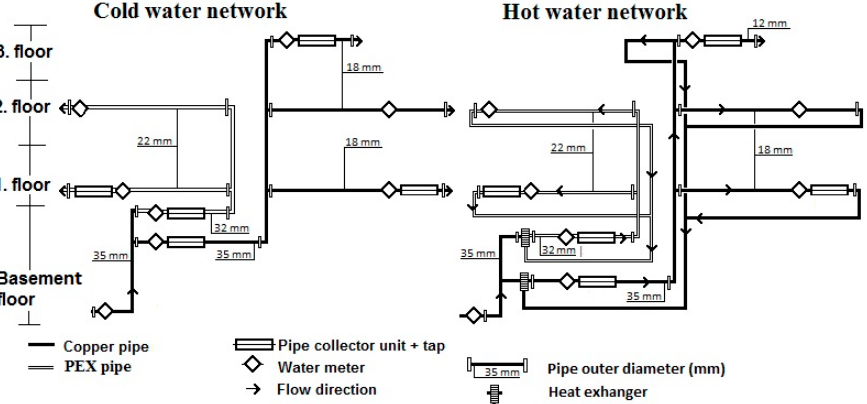
Figure 1. Schematic drawing of the structure of the water systems in office building.